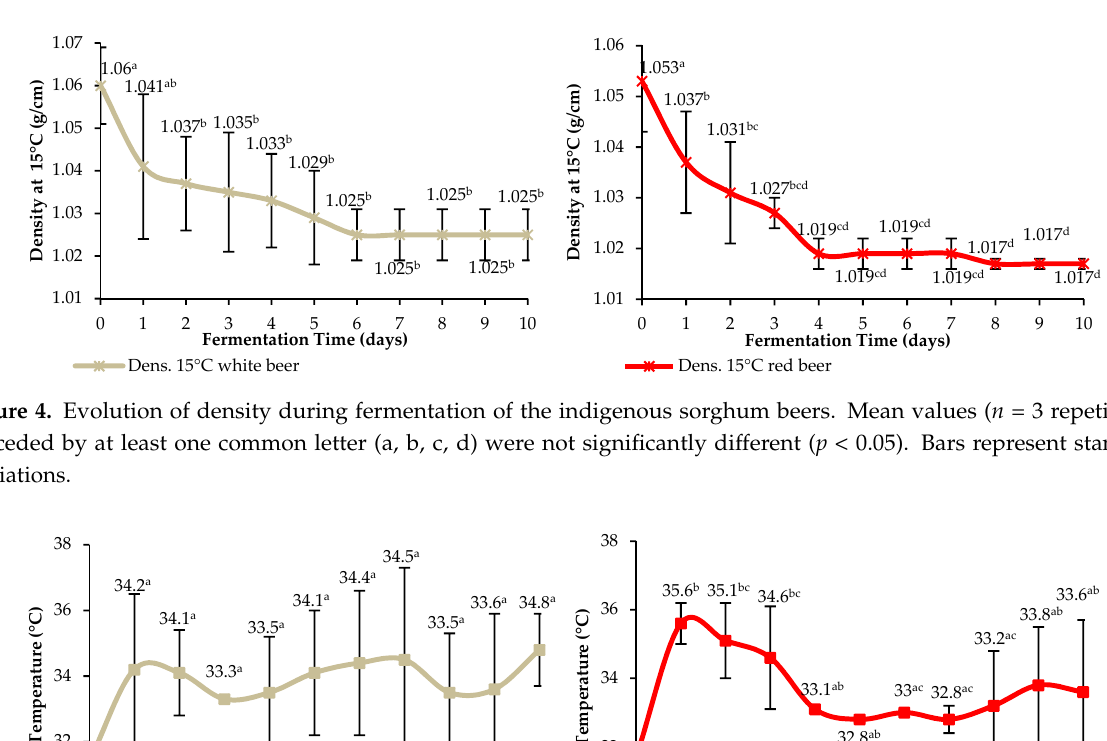
Figure 3. Evolution of total soluble solids and sugars during fermentation of the indigenous sorghum beers. Mean values ( n = 3 repetitions) preceded by at least one common letter (a, b, c, d) were not significantly different ( p < 0.05). Bars represent standard deviations.